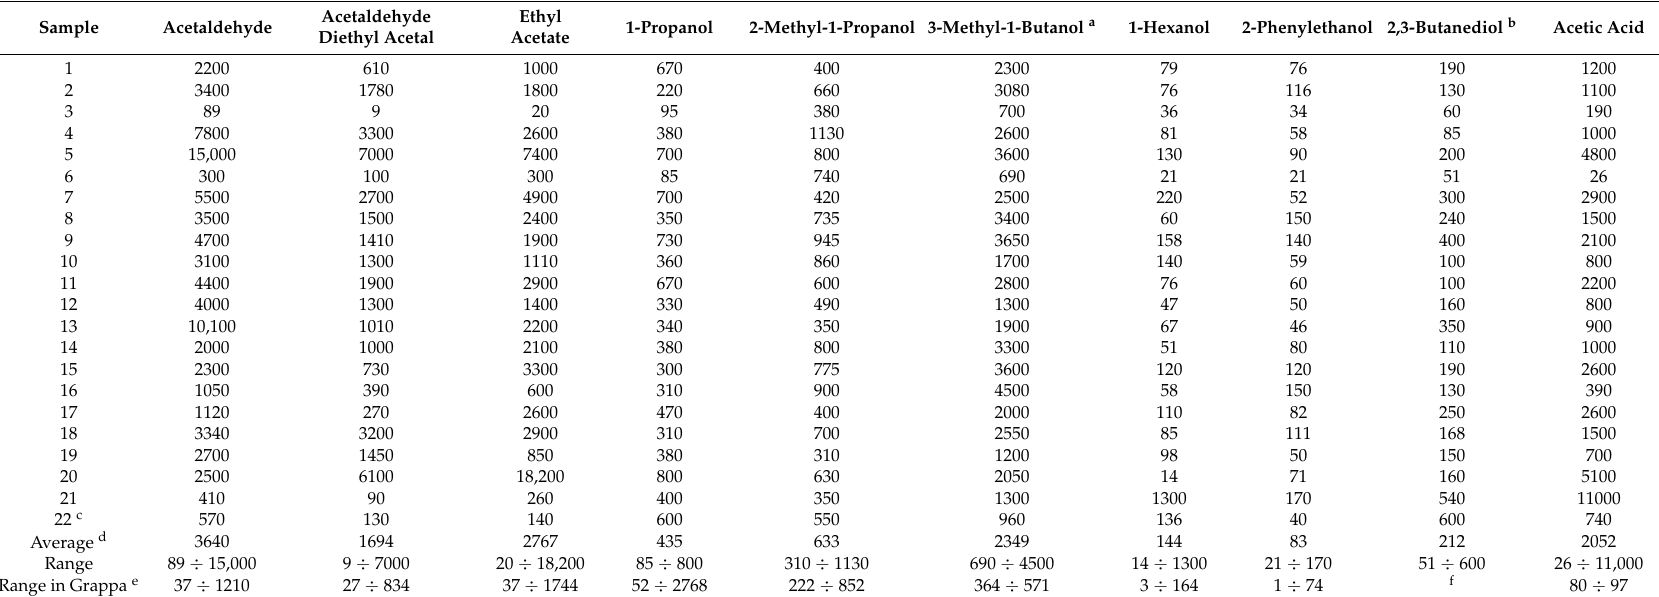
Table 6. Amounts of the principal volatile compounds in Filuferru samples (data expressed as mg dm − 3 in ethanol